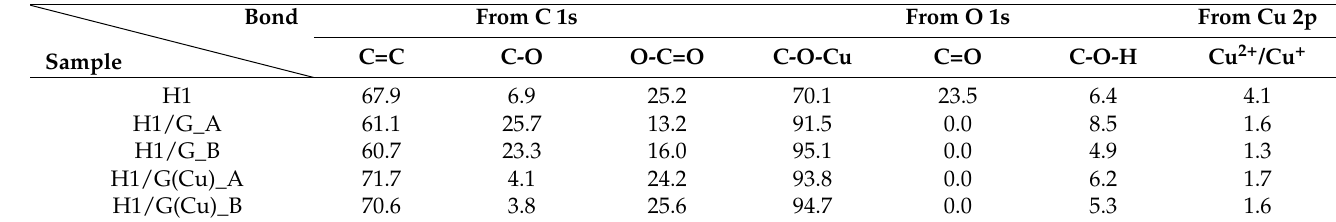
Figure 6. The C 1s ( a ), O 1s ( b ), and Cu 2p ( c ) XPS spectra for H1, H1/G, and H1/G(Cu) composites. Table 2. Contribution of bonds (in %) and Cu 2+ /Cu + ratio in HKUST-1 and its composites with GO and Cu/rGO, calculated from the area under the peaks for the deconvoluted XPS C 1s, O 1s, and Cu 2p